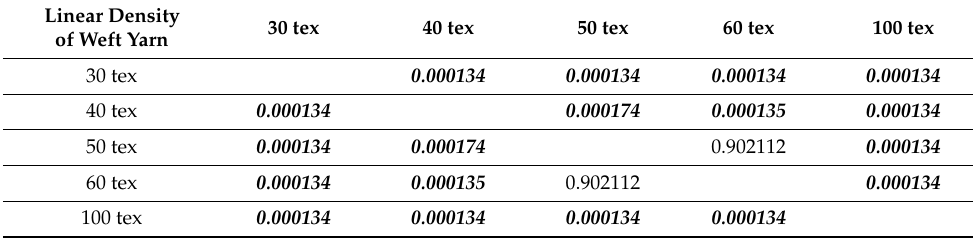
Table 13. The results of the Tukey’s test for the R. Linear Density of Weft Yarn